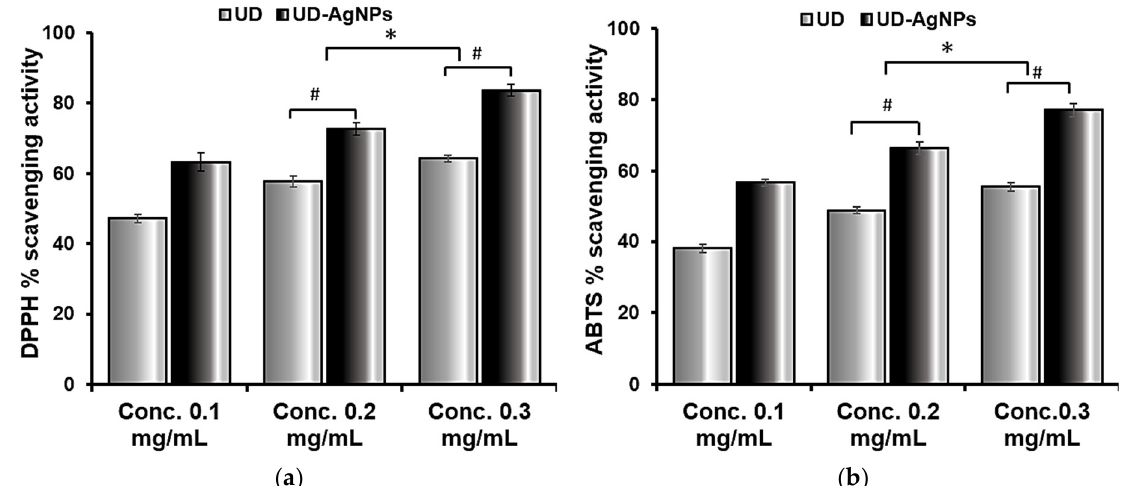
Figure 1. The antioxidant activity of AgNPs produced from U. dioica extract was measured and compared to the DPPH ( a ) and ABTS ( b ) assays. At various concentrations, the antioxidant capacity was measured (0.1, 0.2, and 0.3 mg/mL). The radical scavenging abilities of DPPH and ABTS were dose dependent, implying that as the concentration of AgNPs increased; similarly, the scavenging activities increased against both radicals (the antioxidant potential for DPPH and ABTS was 63.3– 83.5% and 56.7–77.1%, respectively). The data are shown as the mean ± SD ( n = 3). Statistical signif- icance was ascribed as * p < 0.05 (intergroup) and # p < 0.05 (intragroup) compared with and 0.1 mg/mL of the respective groups.